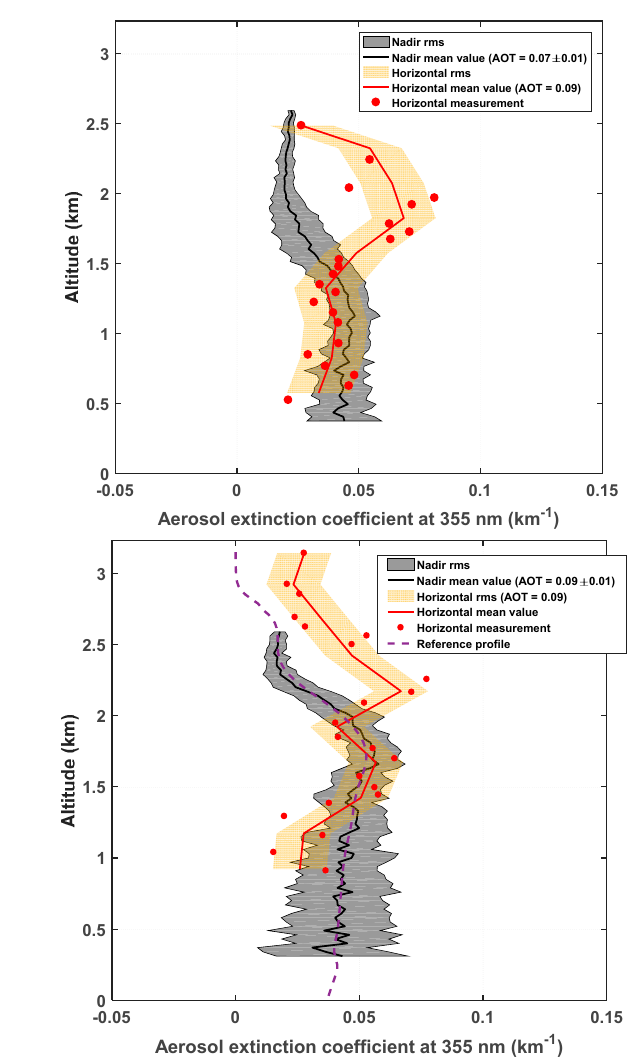
Figure 9. Vertical profile of the aerosol extinction coefficient derived from the vertical (grey area) and horizontal (orange area) Lidar measurements for: ( a ) flight C and ( b ) flight D on 24 June 2015. The reference profile used for the error budget is shown in ( b ) by a purple line.